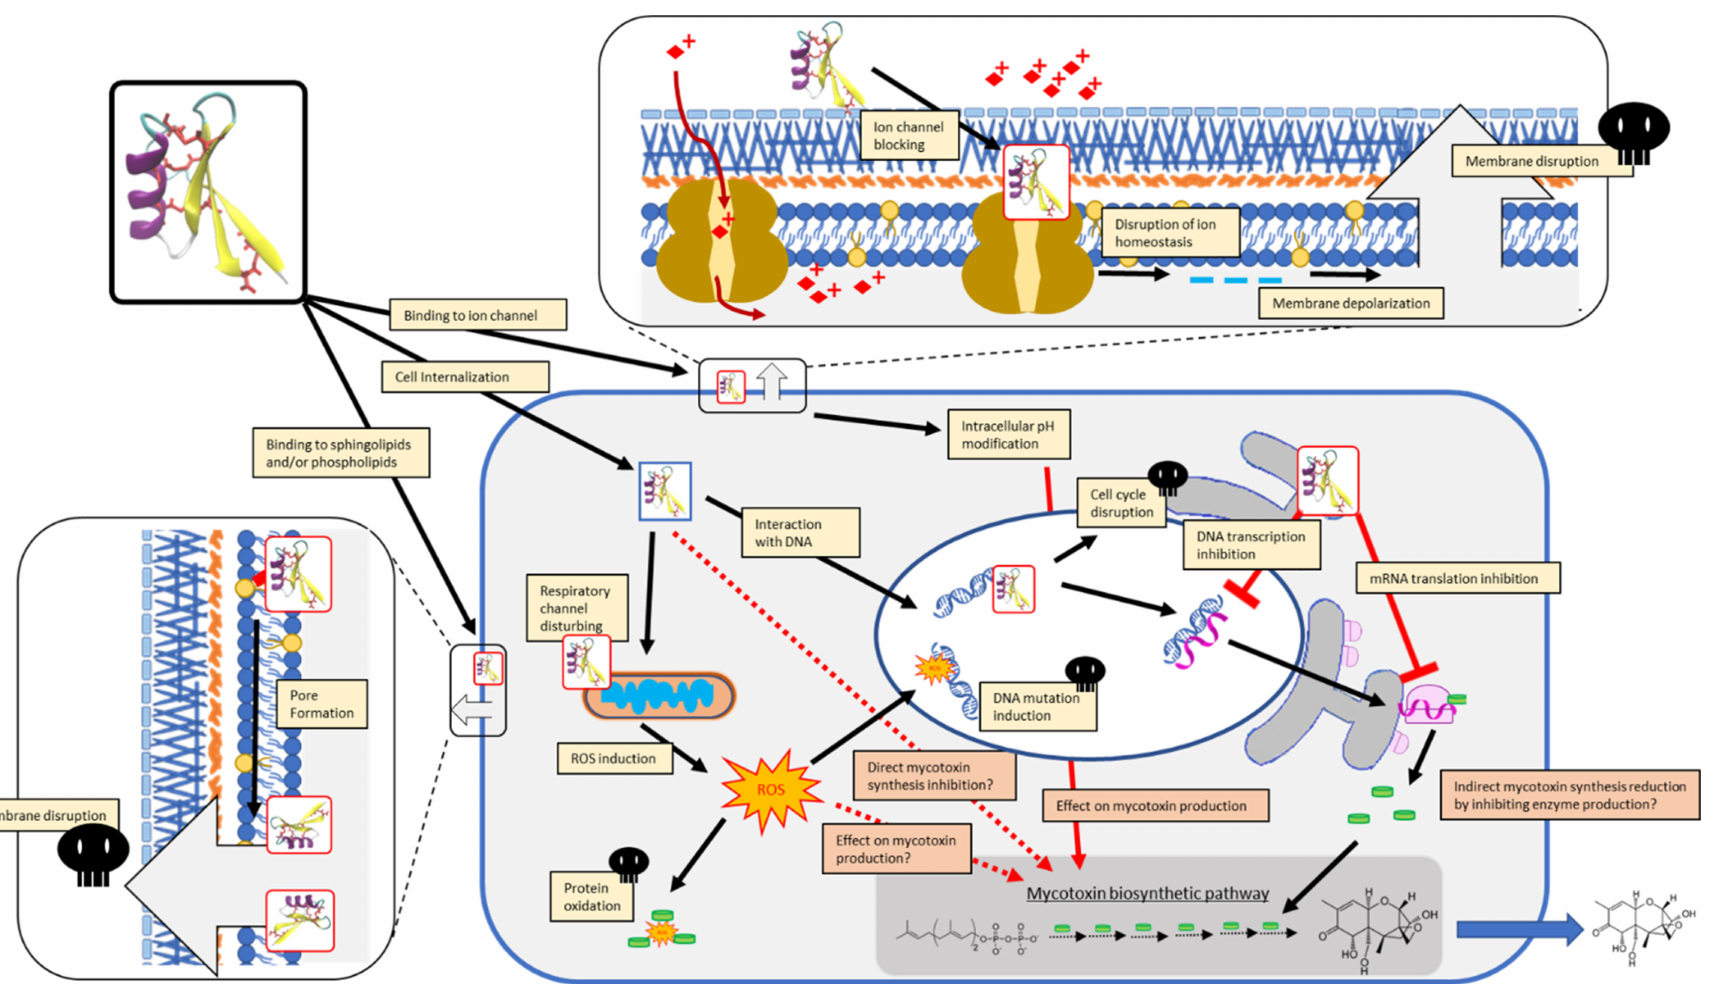
Figure 4. Summary of known and suspected modes of action of defensins displaying antifungal (yellow inserts) and/or antimycotoxin (orange inserts)